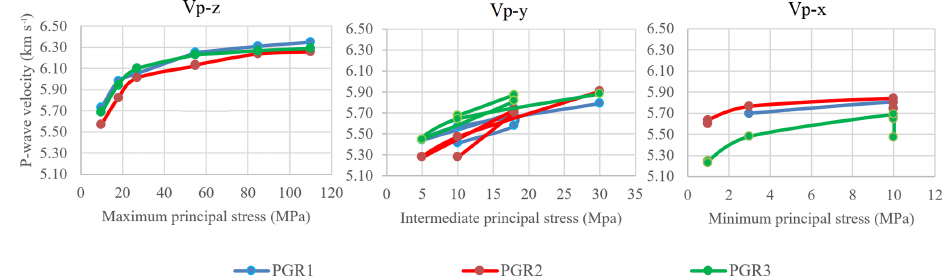
Figure 8. Comparison of compressional wave velocity among the three PGR samples while under a state of true-triaxial stresses (after Nasseri et al., 2016,